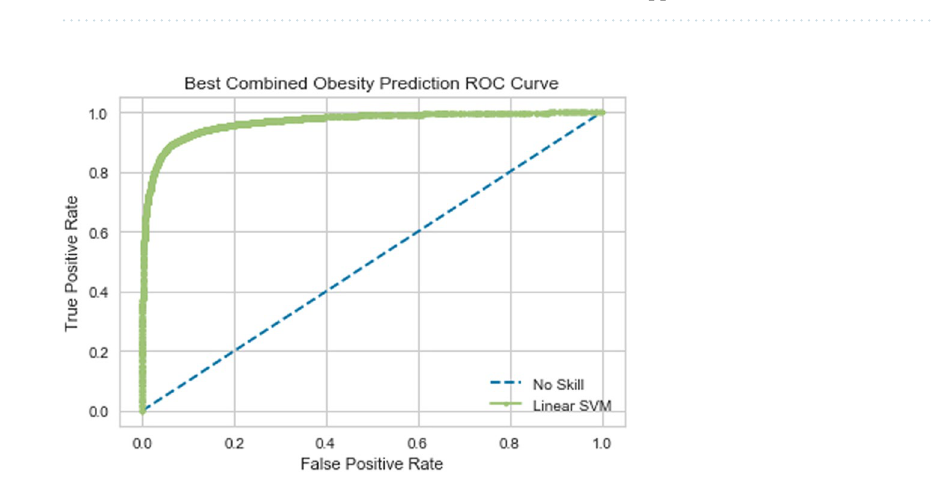
Table 2. Brain and metabolites features included in combined support-vector machine model of obesity.